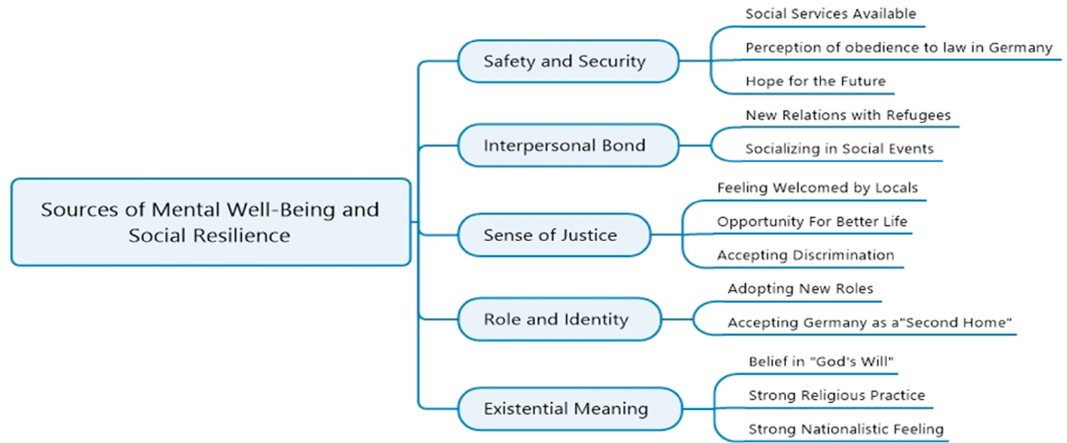
Figure 2. Sources to mental wellbeing and social resilience (based on the ADAPT model [26]).